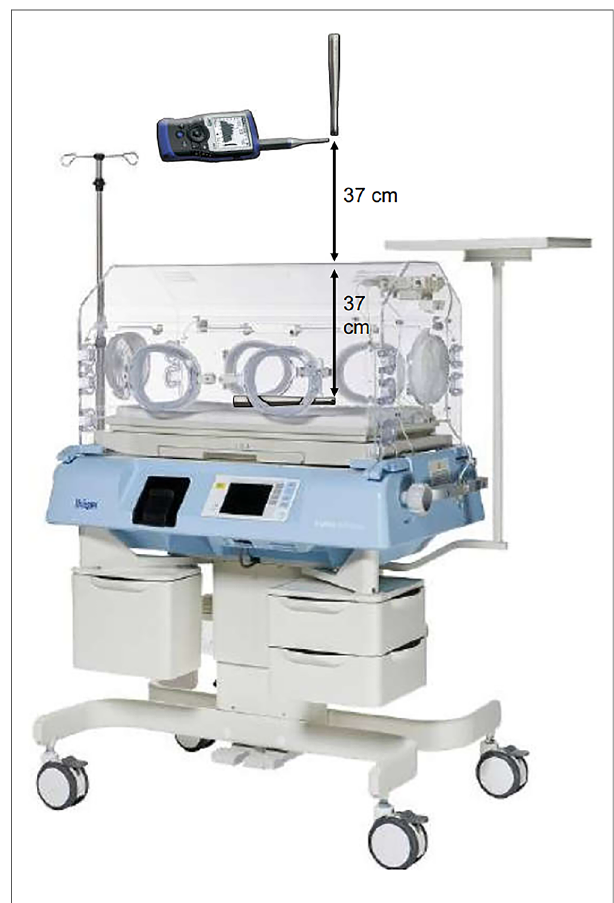
FIGURE 1 Microphone placement for level measurement inside and outside the Dräger Isolette 8000